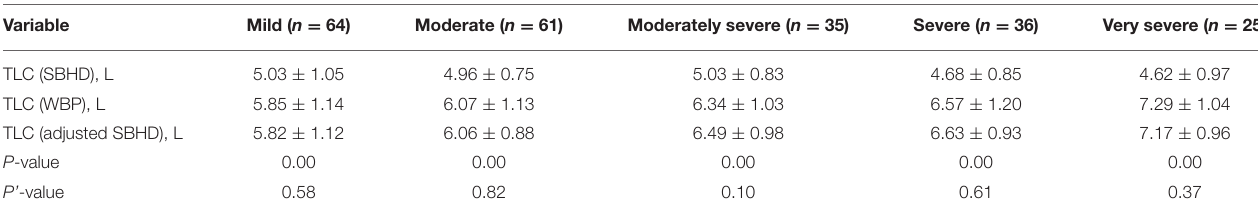
TABLE 4 | Differences (mean ± standard deviation) in TLC in the validation group of subjects stratified by airflow limitation severity.